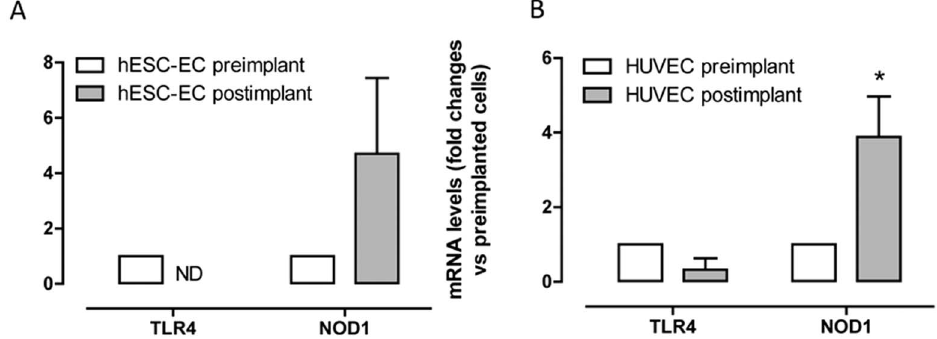
Figure 2. Effect of invivo ‘conditioning’ on TLR4 and NOD1 expression. TLR4 and NOD1 expression in (A) hESC-EC and (B) HUVEC before (pre-implant; open bars) and 21 days after (post-implant; filled bars) implantation in vivo (‘conditioning’). Data are mean 6 SEM and are normalized at unity (1) to gene levels in pre-implant cells. HUVEC; NOD1 pre-implant n=8, post implant n=4: HUVEC; TLR4 pre-implant n=10, post implant n=3. hESC-ECs; NOD1 pre-implant n=6, post implant n=5: hESC-ECs; TLR4 pre-implant n=10, post implant n=6. Data was obtained from 2 independent experiments (using up to 12 rats per group). Statistical significance was determined by one-sample t-test where results were compared to a theoretical control of 1 (*p , 0.05). ND=none